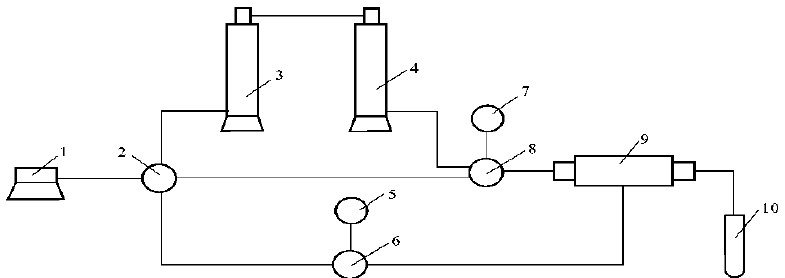
Figure 6. Double-slug experiments measuring the inaccessible pore volume. (1 = constant-flux pump; 2 = six-way valve; 3 and 4 = Intermediate container; 5 and 7 = precision pressure gauge; 6 and 8 = seat; 9 = core holder; and 10 = measuring cylinder).